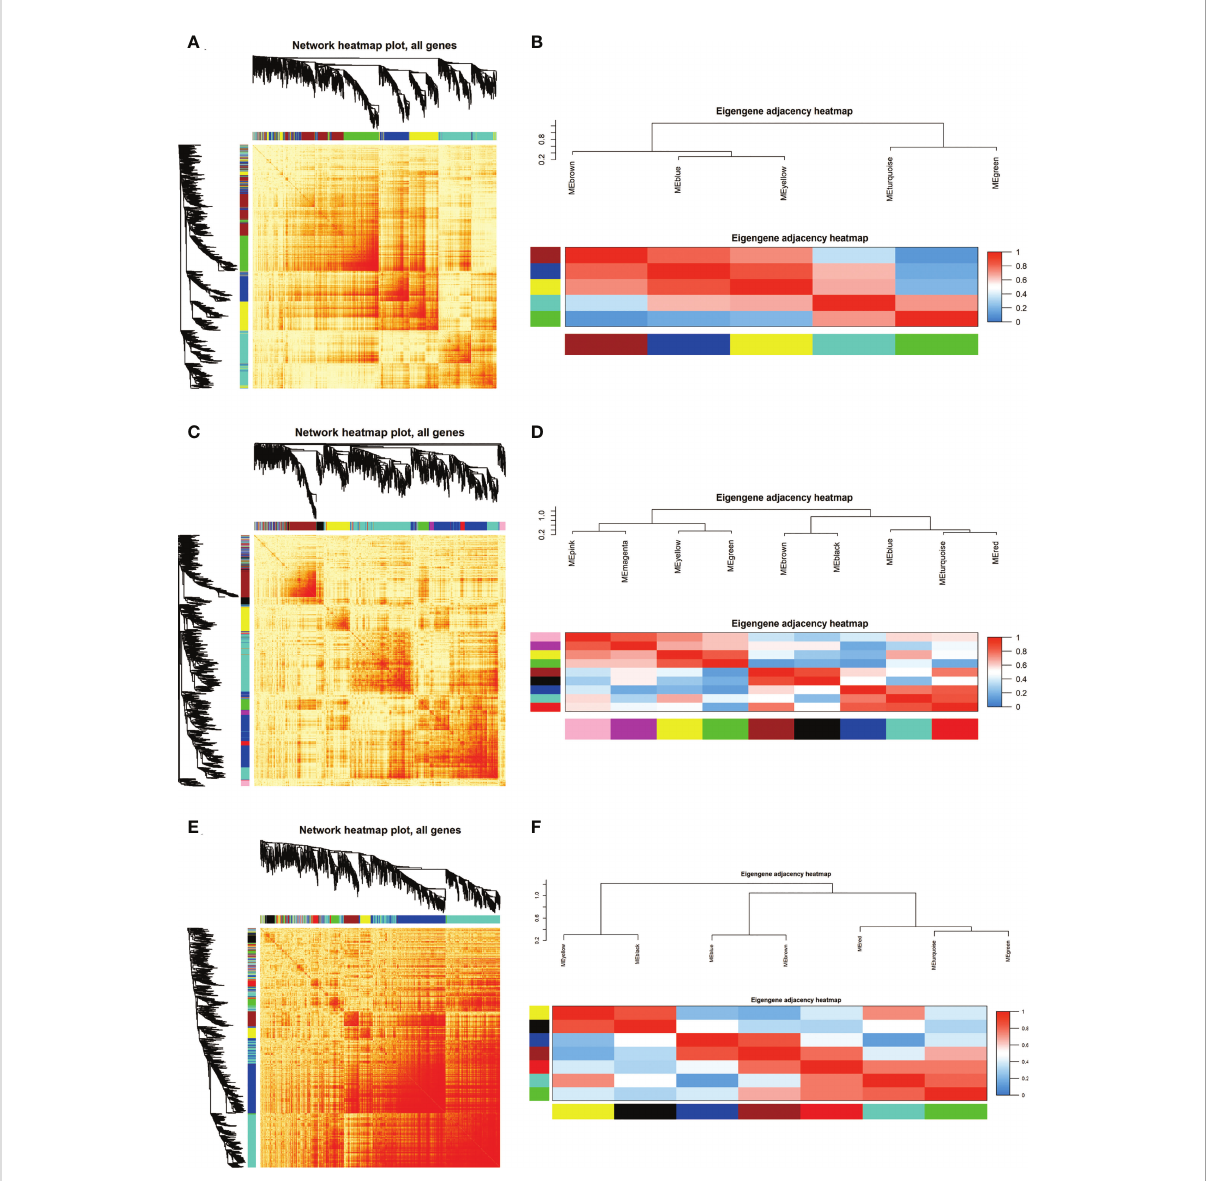
FIGURE 2 Identi fi cation and characterization of autophagy-related genes (ATGs) in Key modules. (A, C, E) Co-expression heatmap plot and correlations for ATGs in GSE8157 (A) , GSE43264 (C) and GSE106724 (E) models. The heatmap depicts the Topological Overlap Matrix among all genes in the analysis. The light color represents low overlap and the progressively darker red color represents higher overlap. Blocks of darker colors along the diagonal are the modules. The gene dendrogram and module assignment are also shown along the left side and the top. (B, D, F) Clustering of module eigengene to calculate the correlation between each module. The eigengene adjacency heatmap for GSE8157 (B) , GSE43264 (D) ,and GSE106724 (F) . Red color represents high adjacency and positive correlation, whereas blue represents low adjacency and negative correlation, as represented by the color legend. The closer the color to Red (to 1), the stronger the